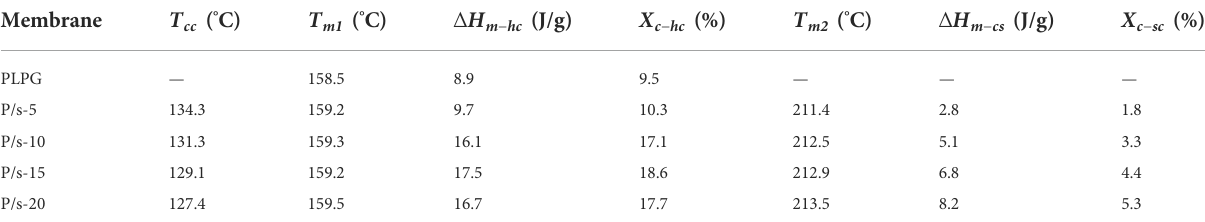
TABLE 1 Thermal property parameters of the PLPG polymers and P/s membranes. Membrane